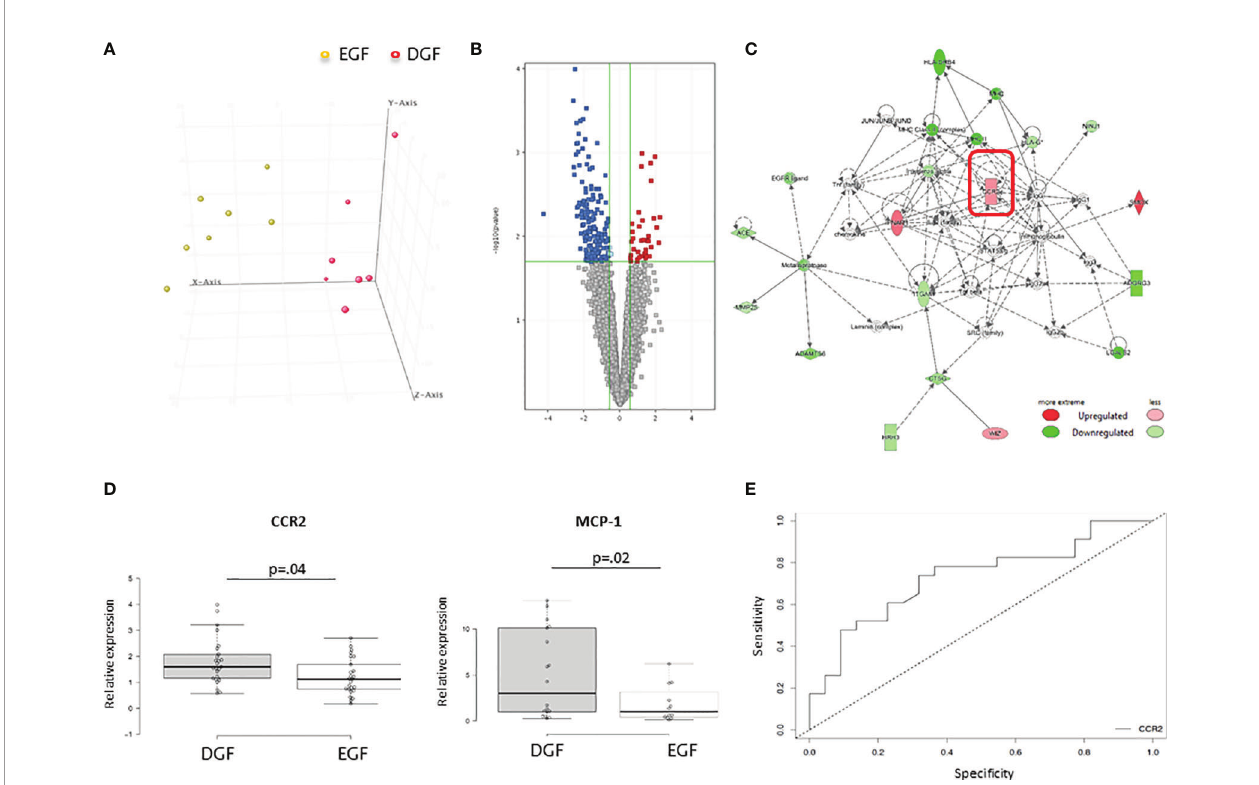
FIGURE 1 | (A) Principal component analysis (PCA) of mRNAs discriminating DGF and EGF subjects. DGF (n = 7) and EGF (n = 7) patients are indicated in red and yellow, respectively. (B) Volcano plot of the 411 differentially expressed genes among DGF patients and EGF patients with a FDR <0.05 and a FC > 1.5. (C) Functional network of the differentially expressed genes among DGF patients and EGF controls. The most signi fi cant network is displayed graphically as nodes (genes) and edges (biological relationship between nodes). The node color intensity indicates the fold change of that gene ’ s expression. Shaded nodes are those genes identi fi ed by our microarray analysis, and empty nodes represent genes automatically included by IPA. The shapes of nodes indicate the functional class of the gene product, and the lines indicate the type of interaction. (D) Validation by quantitative real-time PCR of CCR2 and MCP-1 in PBMCs isolated from an independent group of 25 DGF and 25 EGF patients for CCR-2 gene expression and 11 DGF and 11 EGF for MCP-1 gene expression. Data are expressed as median and 25th and 75th percentiles in boxes and 5th and 95th percentiles as whiskers. (E) ROC curve analysis to evaluate the sensitivity and speci fi city of CCR2 as a predictive marker of DGF.